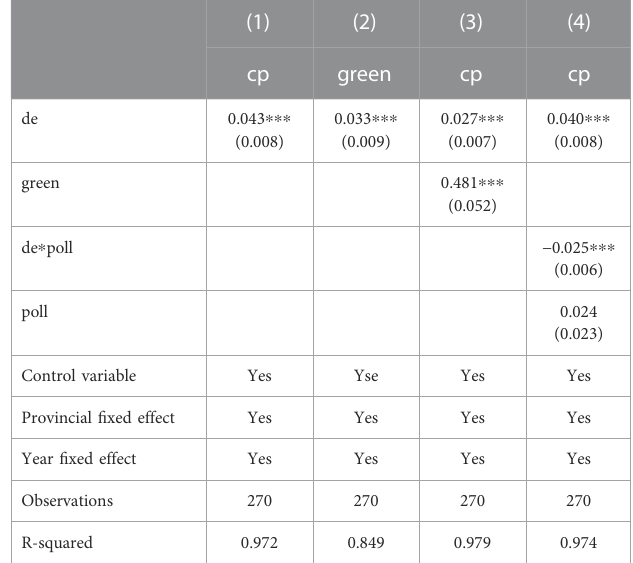
TABLE 6 Regression results of mediating effect and moderating effect